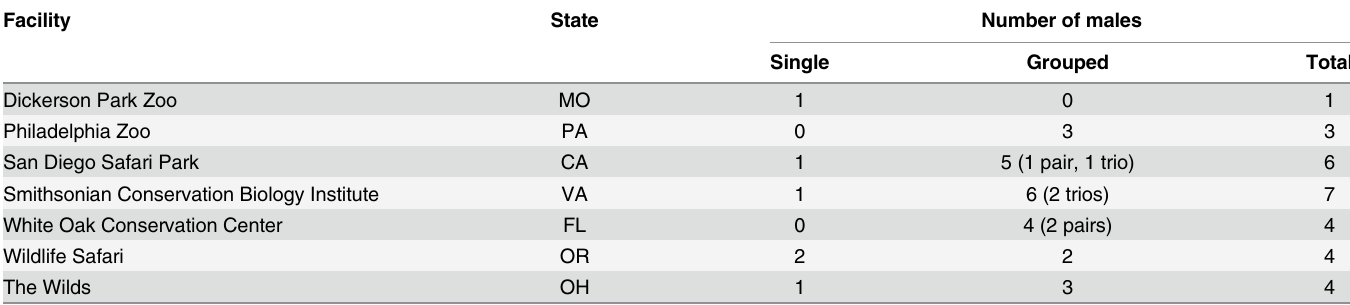
Table 1. Demographic and housing information for male cheetahs (n =